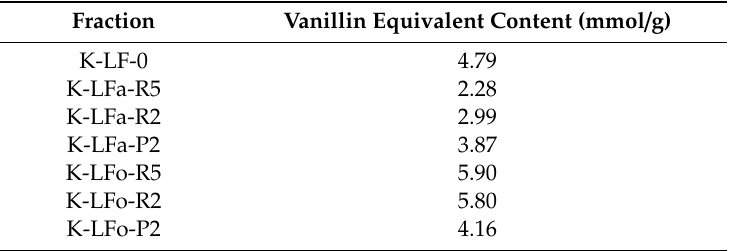
Table 6. Results of the determination of phenolic hydroxyl groups expressed as vanillin equivalents in the lignin fractions recovered from aqueous and organic processes applied on K-LF-0 (expressed in mmol / g) in the dry lignin. Estimated standard errors ± 0.2 mmol / g vanillin equivalent (1 σ , from calibration